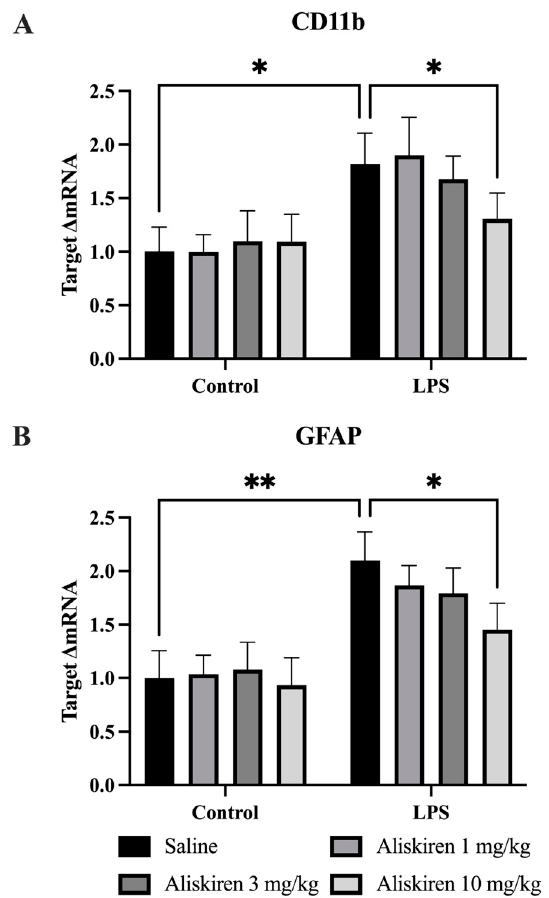
Figure 4. Assessment of Aliskiren Effects on Glial Markers Activation in Prefrontal Cortex. ( A ) The effects of Aliskiren on LPS-induced upregulation of CD11b. ( B ) The effects of Aliskiren on LPS- induced upregulation of GFAP. n ≥ 6 mice/group. * p < 0.05; ** p < 0.01.